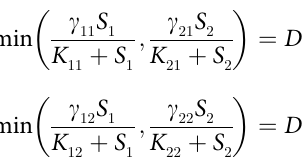
Fig 8. Growth dynamics of five technologies competing for one resource as predicted by Eq (28). Parameters of simulation (arb. units): K = (1.02 0.9 1.09 1.17 0.91) > , γ = (0.95 1.1 0.81 0.88 0.98) > , q = (1.04 0.83 0.97 0.84 1.2) > , D = (0.62 0.5 0.61 0.54 0.53) > , r = 2, d = 0.2, R (0) = 0, and N (0) = (0.1 0.1 0.1 0.1 0.1) > . Because S � the smallest, technology 2 competitively displaces all other rivals by reducing the resource to a level at which they cannot maintain their business.